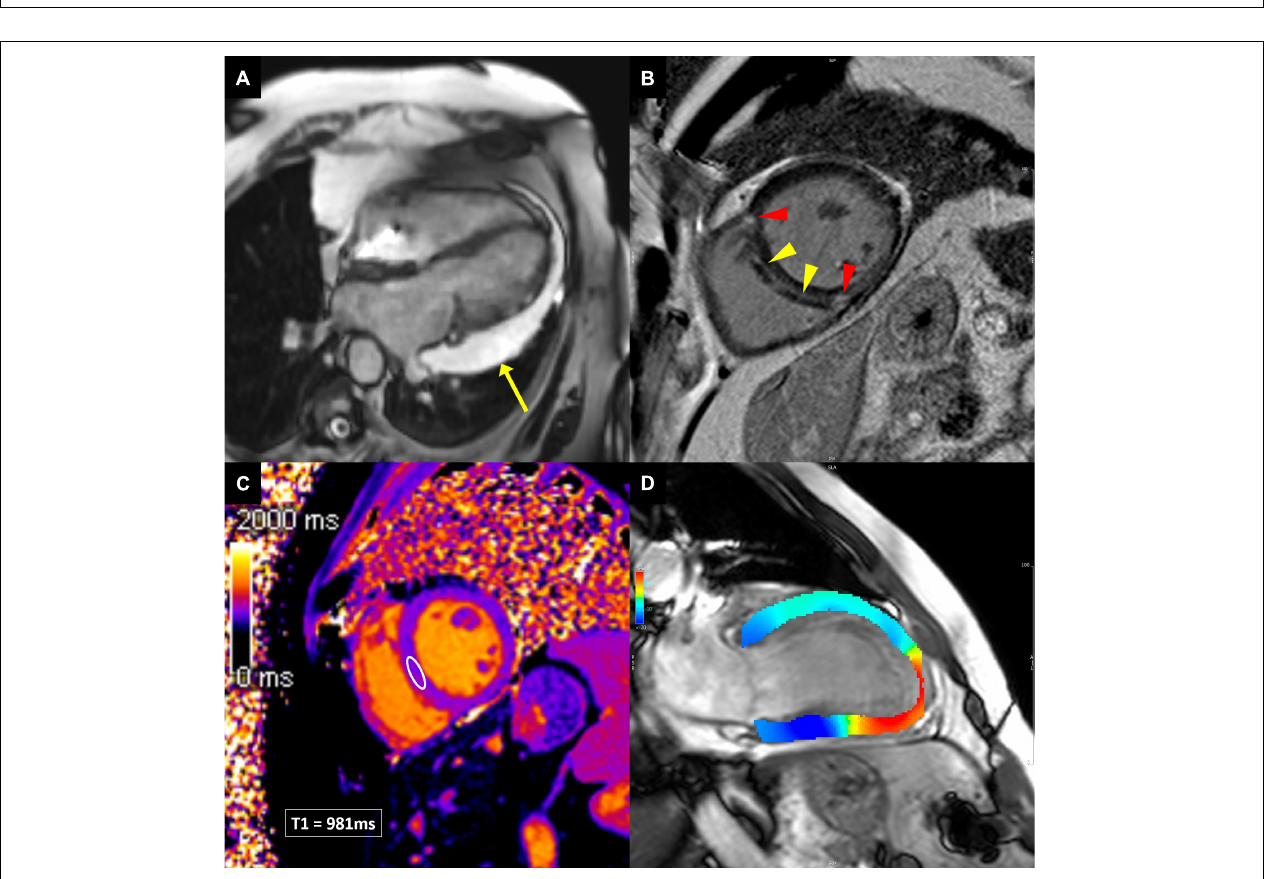
FIGURE 5 | Cardiovascular magnetic resonance techniques to evaluate cardiotoxicity. (A) Balanced steady-state free precession cine image in breast cancer patient demonstrating large pericardial effusion next to the lateral wall of the left ventricle (yellow arrow). (B) Late gadolinium enhancement image, showing linear midwall myocardial fibrosis (yellow arrowheads), indicating non-ischemic dilated cardiomyopathy. In addition, the anterior and inferior right ventricular insertion point fibrosis is present (red arrowheads), which is a non-specific finding. (C) Native T1 image, allowing T1 measurements in any desired myocardial area of interest (white ellipse in the ventricular septum). (D) Feature-tracking strain image, showing impaired longitudinal strain in the apex and apical inferior wall (red color), consistent with apical myocardial infarction.